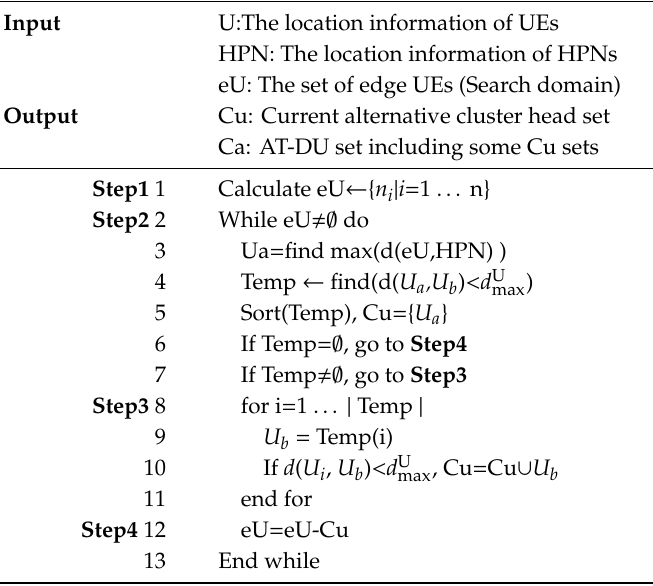
Algorithm 1: Distance-based AT-DU clustering